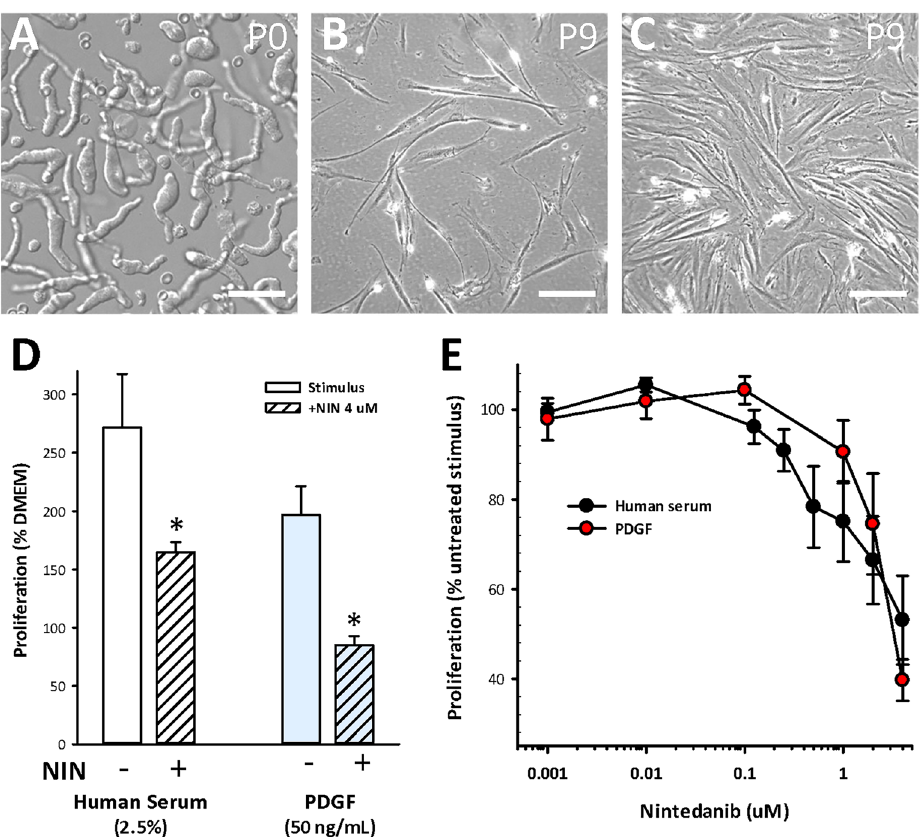
Figure 8. NIN is effective in inhibiting growth of human intestinal smooth muscle cells in vitro. Human intestinal circular smooth muscle cells were obtained from the terminal ileum and maintained to passages 9–12 for assay of growth. Each cell line originates from a different subject. ( A ) Nomarski microscopy image showing appearance of freshly isolated human CSMC. ( B , C ) Phase contrast images of low density and confluent cultures at P9, showing elongated bipolar spindle shapes. Scale bars, ( A ) 40 µm; ( B , C ) 200 µm. ( D ) NIN (4 µM, 48 h) suppressed proliferation of human CSMC in response to either adult human serum or PDGF-BB (n = 5 cell lines in triplicates). ( E ) Similar concentration–response relationships of inhibition of human serum or PDGF-BB included growth by NIN (n = 3 cell lines). Data, p < 0.05 vs stimulus alone for human serum + NIN ≥ 0.5 µM; PDGF + NIN ≥ 2